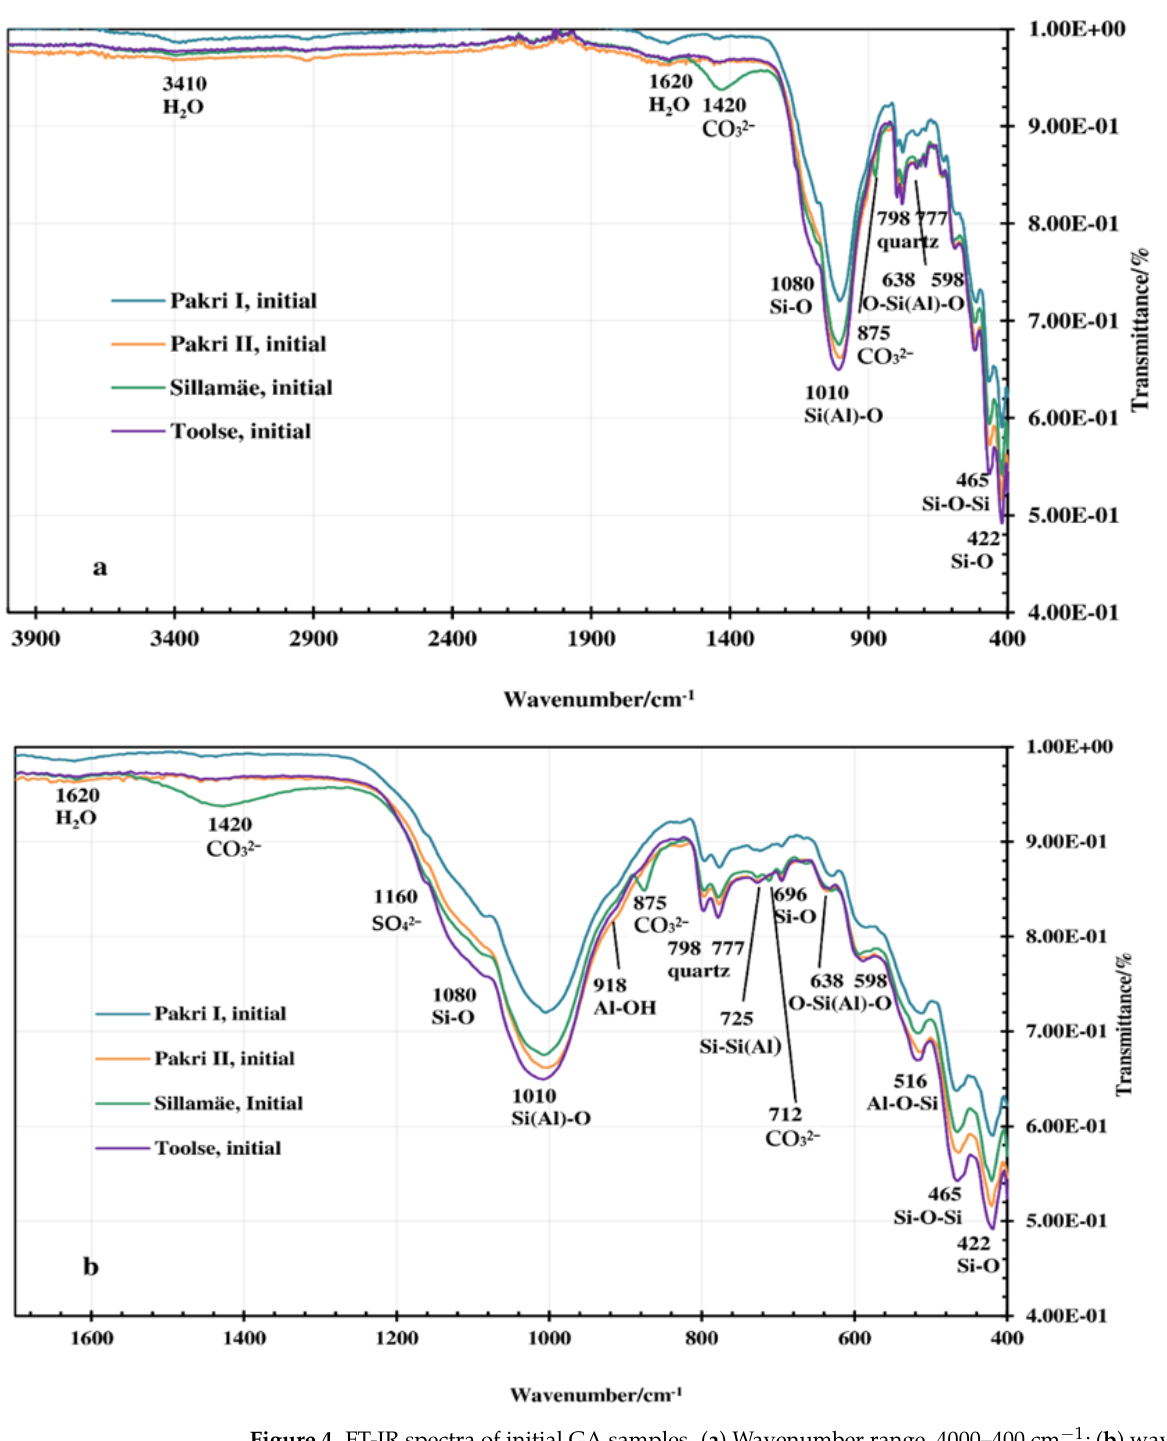
Figure 4. FT-IR spectra of initial GA samples. ( a ) Wavenumber range, 4000–400 cm − 1 ; ( b ) wavenumber range, 1700–400 cm − 1 .